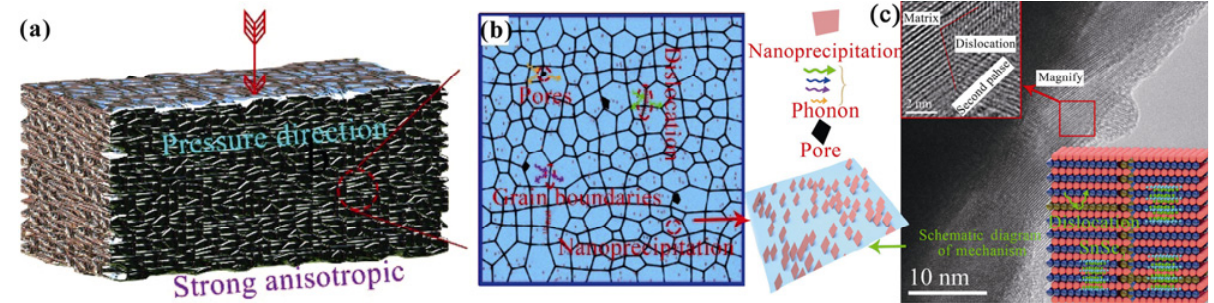
Fig. 11 Schematic diagrams of phonon scattering effects occurring in Sn 0.98 Cu 0.01 Ce 0.01 Se with nanoprecipitation: (a) Macroscopic diagram of anisotropy of sample. (b) Atomic arrangement of sample. (c) Scattering factor effect with different scales on phonon